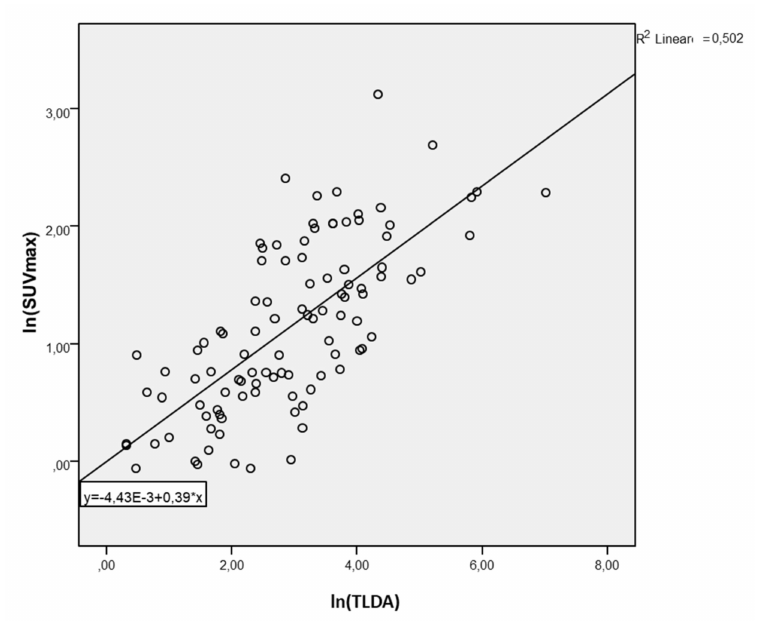
Figure 3. Univariate analysis model of the association between lnSUVmax and lnTLDA.